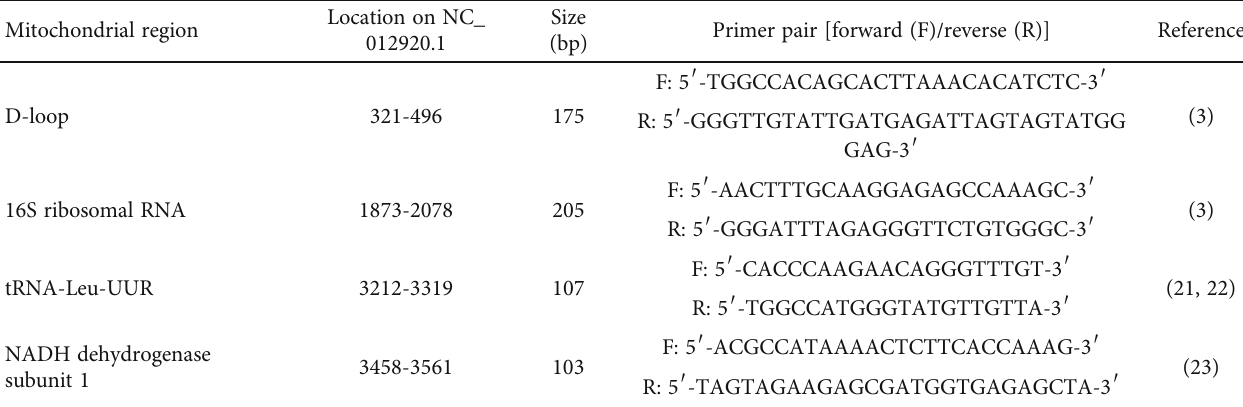
Table 1: PCR primers and their sequences used for exosomal mtDNA ampli fi